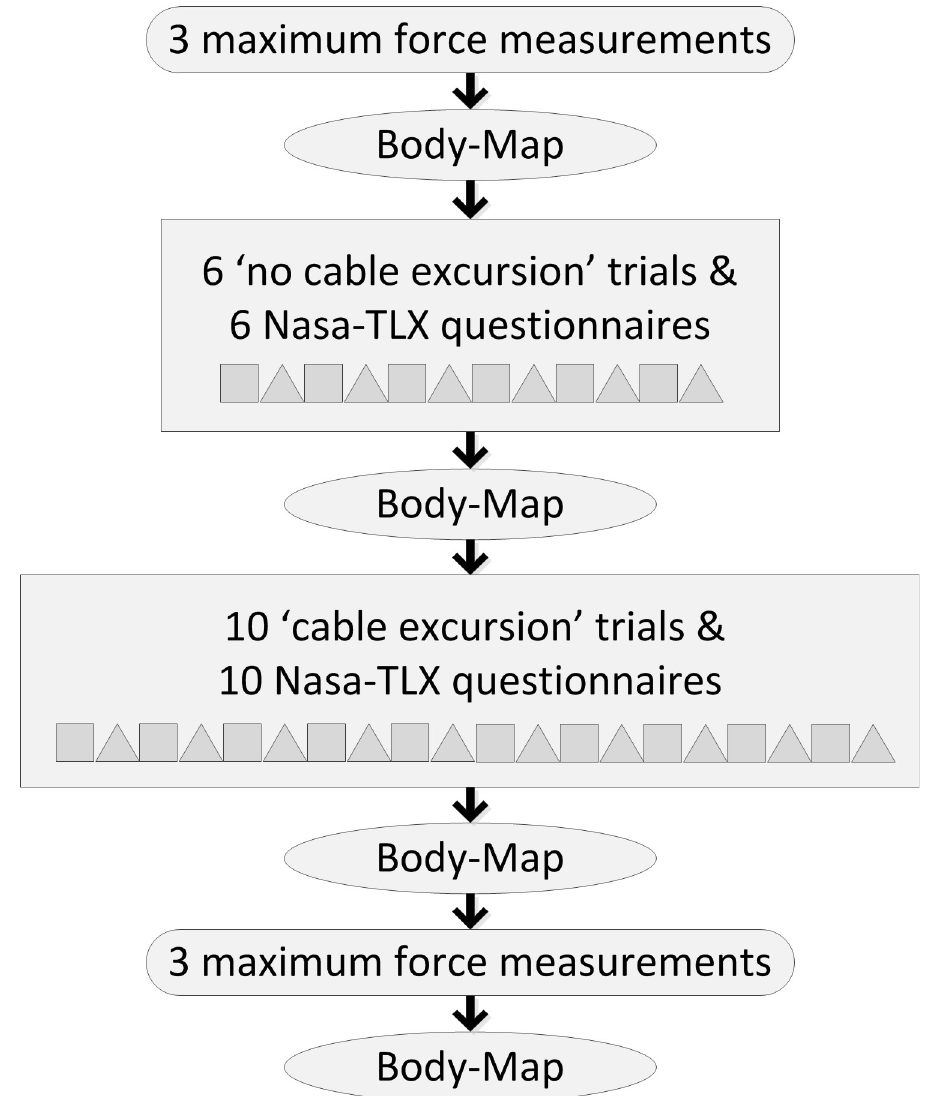
Fig 3. Experimental procedure. The flowchart of the experimental procedure illustrates the chronologic order of maximum force measurements (rounded rectangles), body-map questionnaires (circles), force reproduction experiments with and without cable excursion (rectangles) with alternating force reproduction trials (squares) and Nasa-TLX questionnaires (triangles).